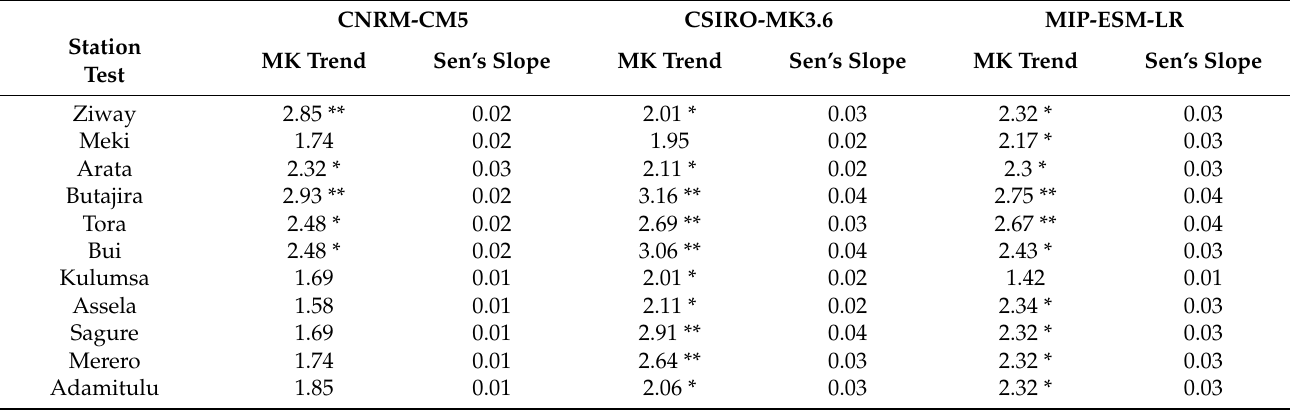
Table A5. Mann–Kendall trend and Sen’s slope estimator value for annual baseline and historical T min at Ziway Lake Basin from 1983 to